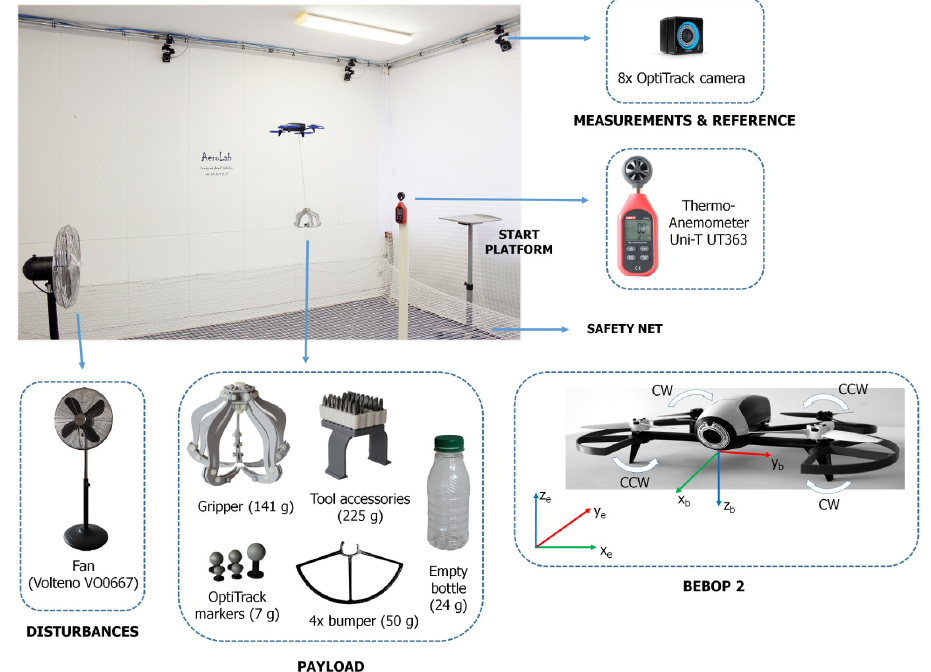
Figure 1. The Bebop 2 quadrotor (and its coordinate system) during one of the initial experiments